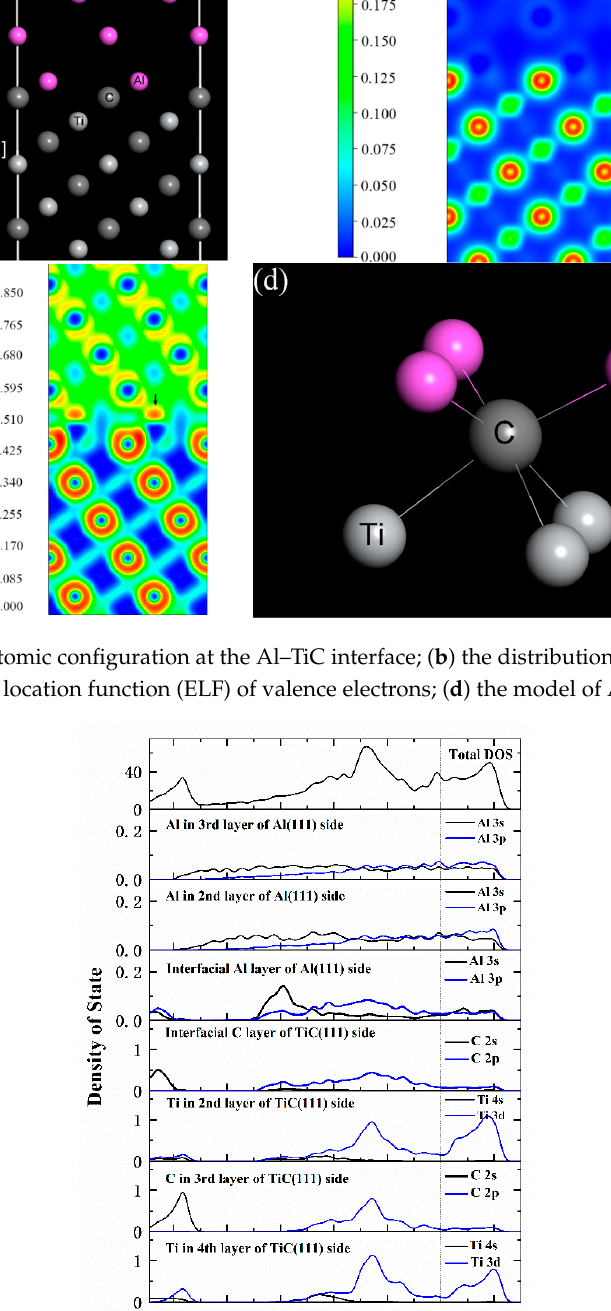
Other Experimental This Theoretical Values Work Results